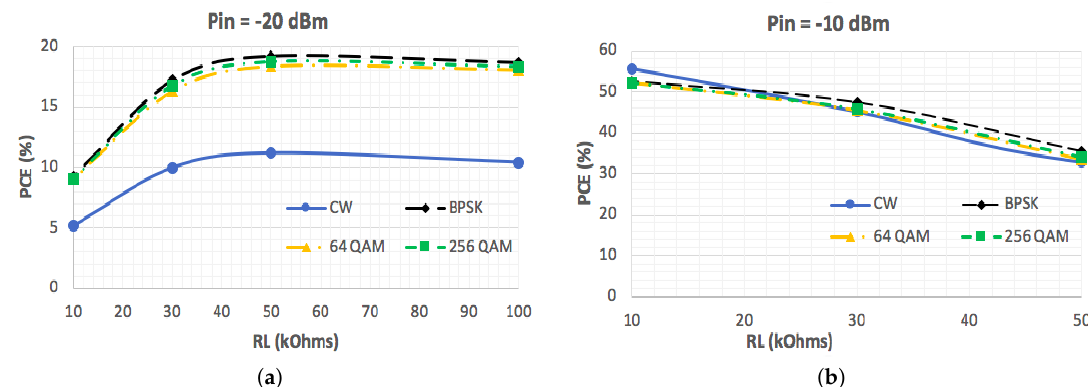
Figure 16. Measurement results of the proposed RFEH system in an anechoic chamber: ( a ) Output voltages at 10 M Ω with CW signal and modulated signals and ( b ) PCE with a CW signal.